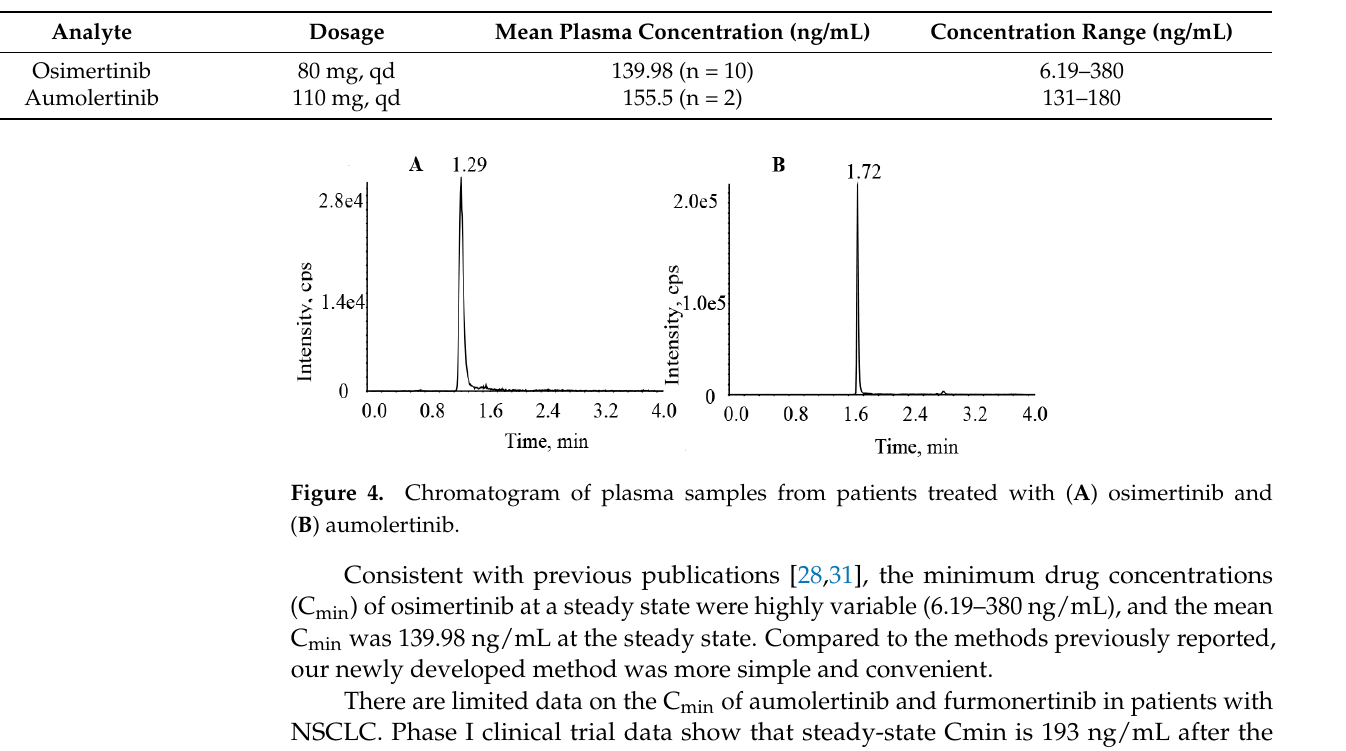
Table 4. Steady-state trough concentrations of analytes in patient plasma.